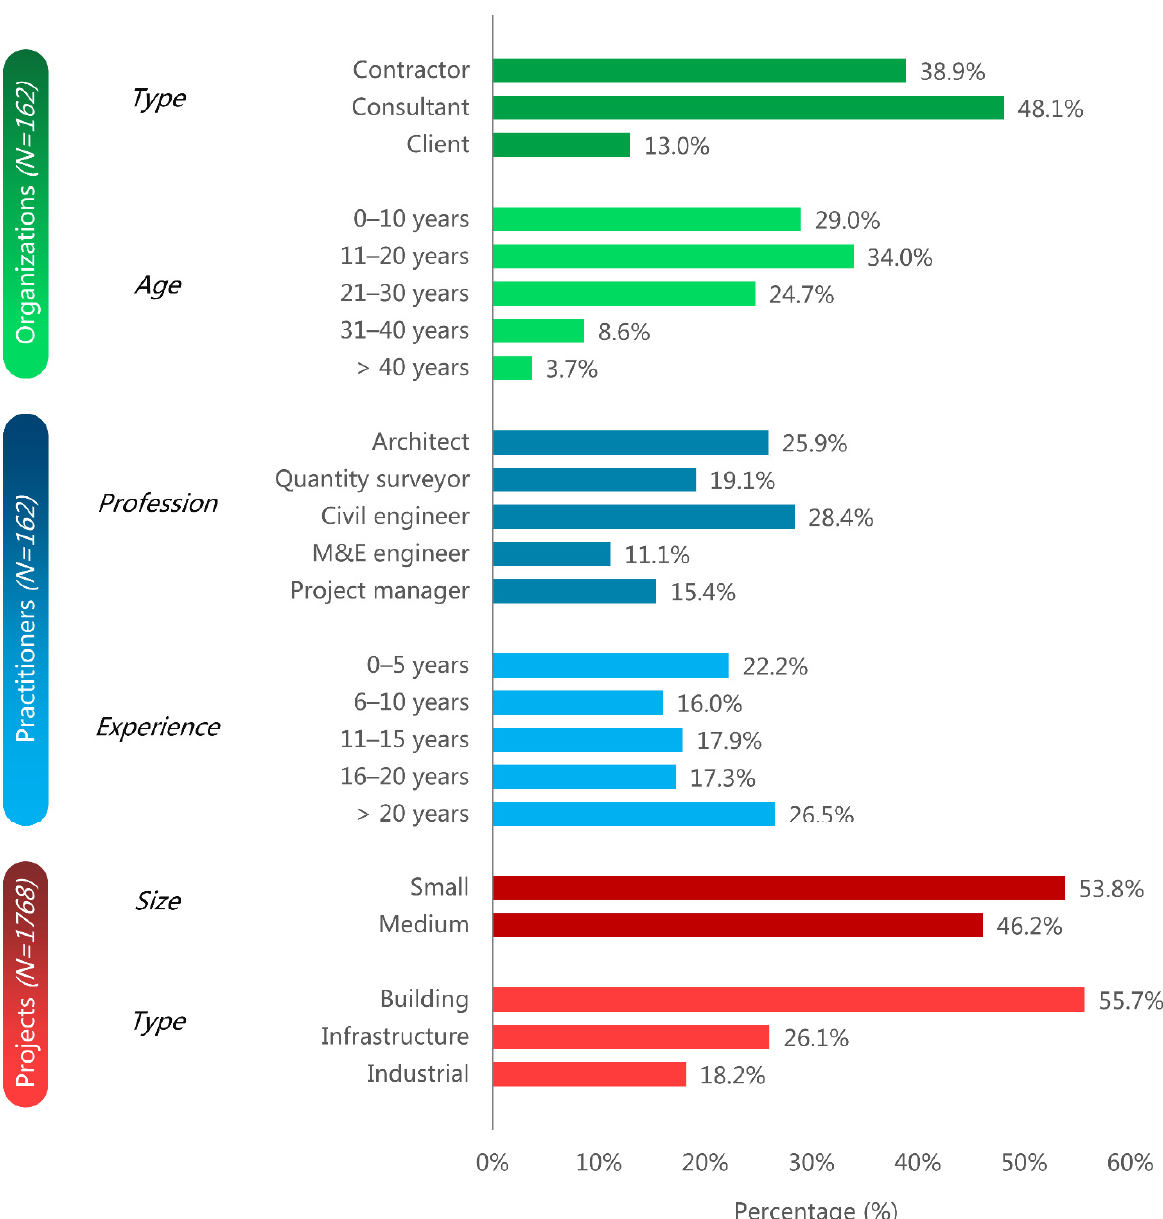
Figure 2. Profile of the surveyed organizations, practitioners, and projects.